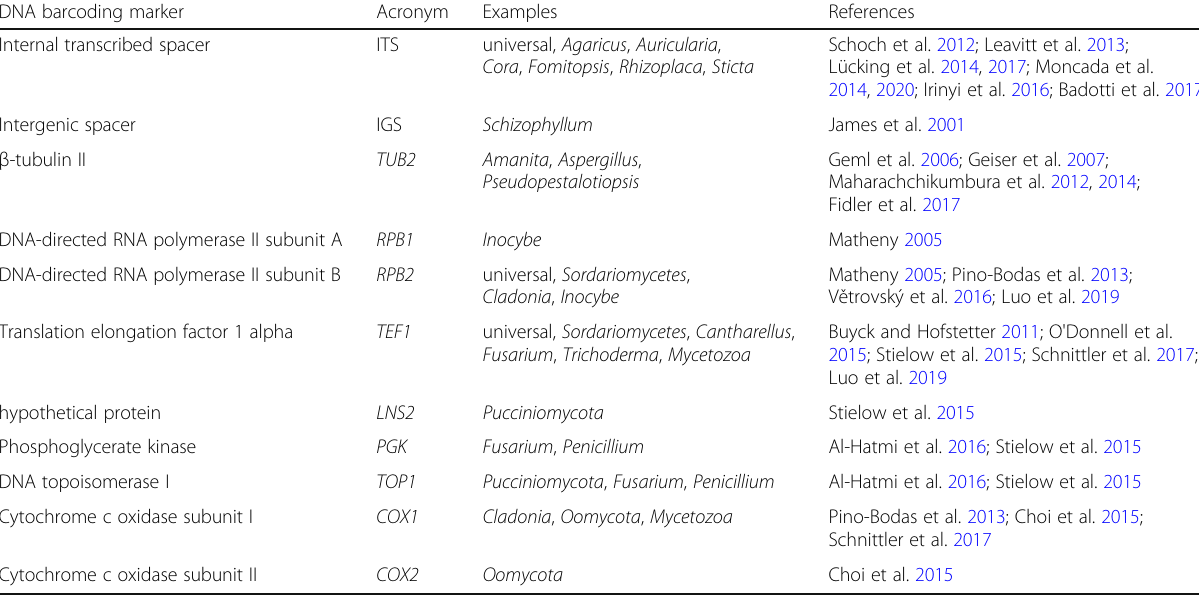
Table 1 DNA Barcoding markers proposed for fungi, their recommended nomenclature and selected examples (see also Stielow et al. 2015; Xu